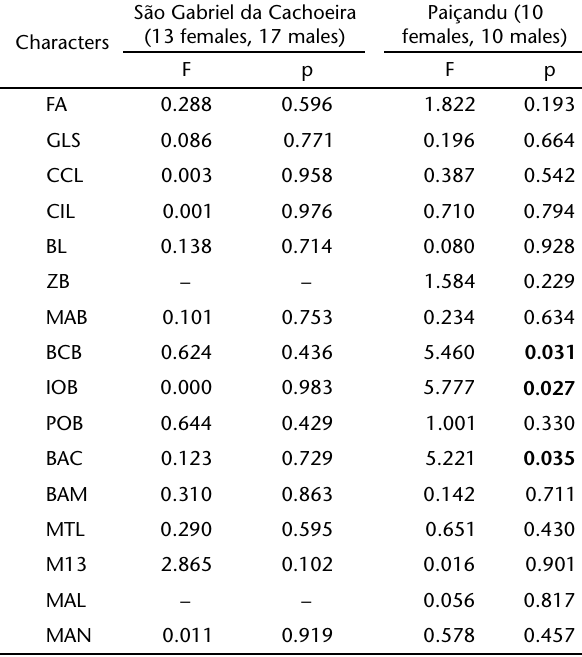
Table II. F and p values (ANOVA) for secondary sexual dimorphism in craniometric and external measurements of two samples (São Gabriel da Cachoeira, Amazonas, Brazil, and Paiçandu, Paraná, Brazil) of Myotis albescens . Numbers in bold indicate statistically significant dimorphism (p <